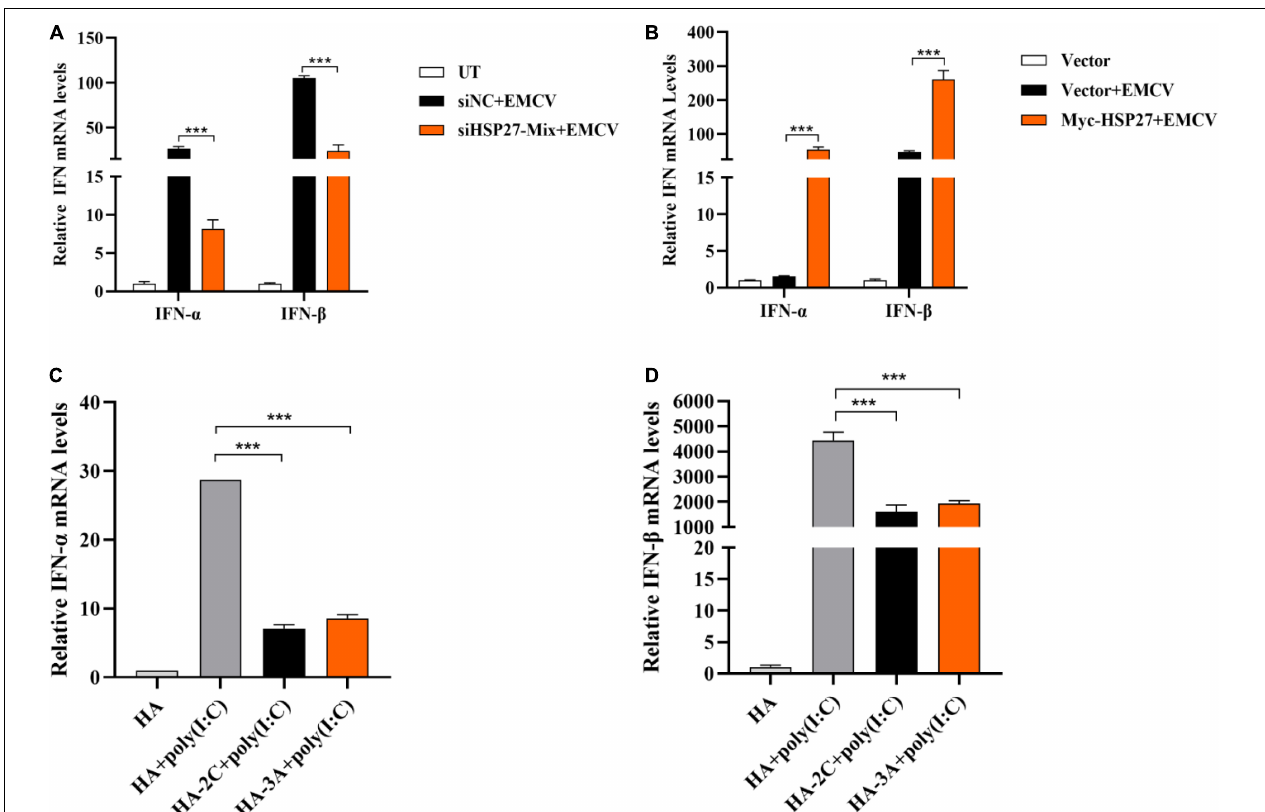
FIGURE 5 | HSP27 positively regulates the production of encephalomyocarditis virus (EMCV)-triggered IFN-I. (A) A549 cells were transfected with either 150 nmol of siHSP27-Mix or siNC for 36 h before infecting with EMCV at an multiplicity of infection (MOI) of 0.01 for 36 h. IFN- α and IFN- β mRNA levels were measured by RT-qPCR. Untreated group (UT) cells were used as control. (B) A549 cells were transfected with Myc-HSP27 (1 µ g) or pCMV-Myc (1 µ g) plasmids for 36 h before infecting with EMCV at an MOI of 0.01 for 36 h. IFN- α and IFN- β mRNA levels were measured by RT-qPCR. A549 cells transfected with pCMV-Myc (1 µ g) plasmid were used as control. A549 cells were transfected with pCMV-HA (0.5 µ g), HA-2C (0.5 µ g) or HA-3A (0.5 µ g) for 24 h, and then transfected with poly (I:C) for 8 h. (C) IFN- α mRNA levels were measured by RT-qPCR. (D) IFN- β mRNA levels were measured by RT-qPCR. Data were represented as mean ± SD of three independent experiments and were measured in technical duplicate, *** P <